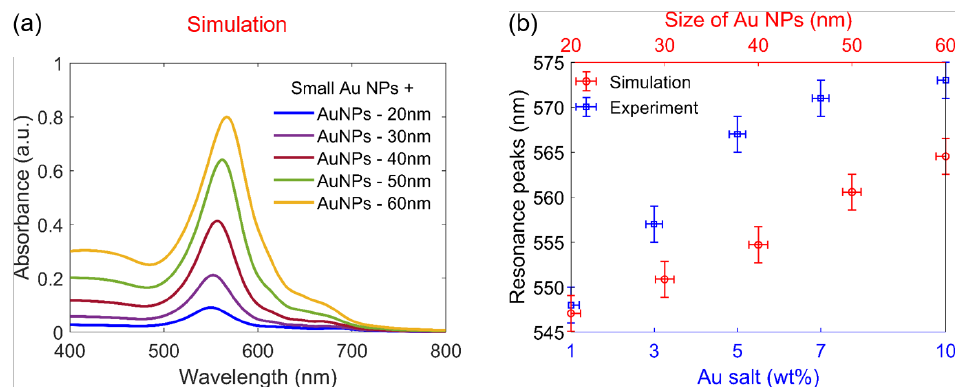
Figure 7. Absorption spectra of Au NPs: ( a ) Theoretical calculation of the regions containing Au NPs with different sizes from 20 nm to 60 nm surrounded by many small (10 nm) Au NPs. ( b ) Comparison of resonance peak positions between simulation and experiment. The error bars indicated for each point are as follows: ± 1 nm for Au NPs size; ± 0.2 wt.% for Au salt concentration; and ± 2 nm for SPR peak